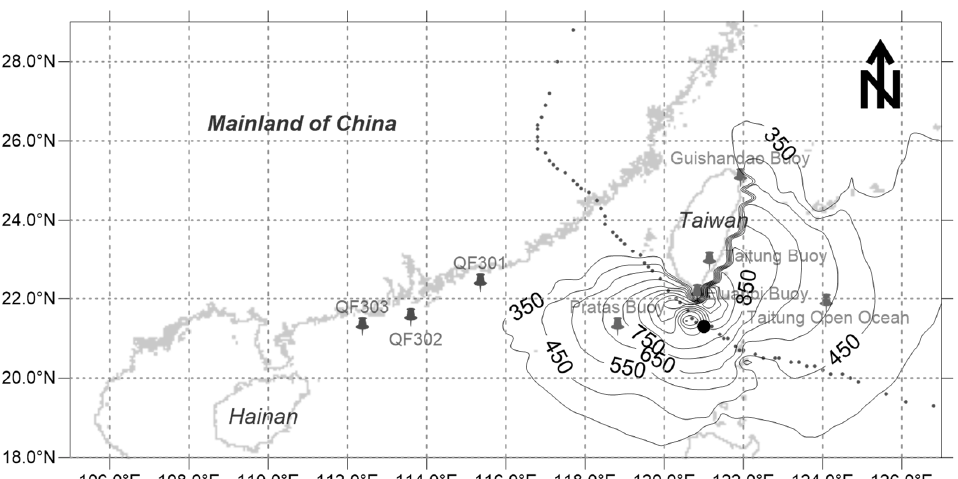
Figure 8. A wave field (unit: cm) induced by the wind field from the model with a varying parameter b but without an asymmetric structure (B3-A1-A1) at Eluanbi Station peak wave time during Typhoon Meranti (142016), where the bigger black dot is the location of the typhoon’s center.